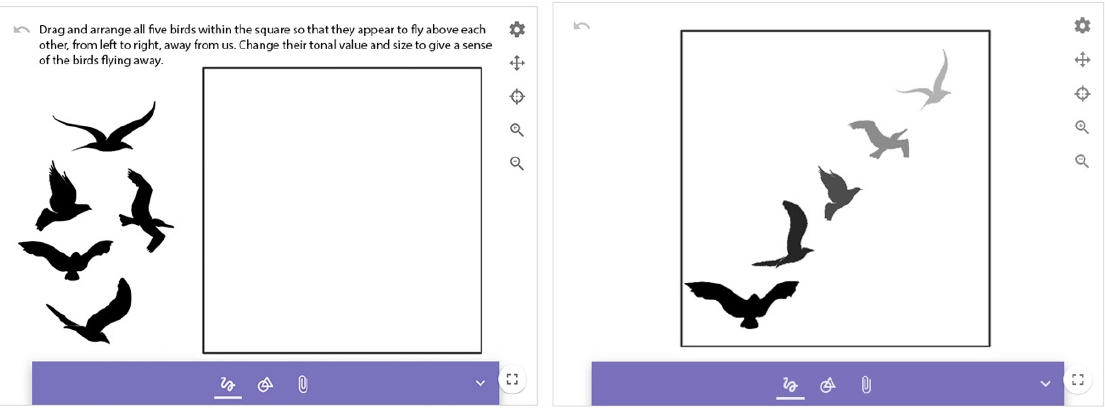
Figure 6. Two-dimensional spatial representation.